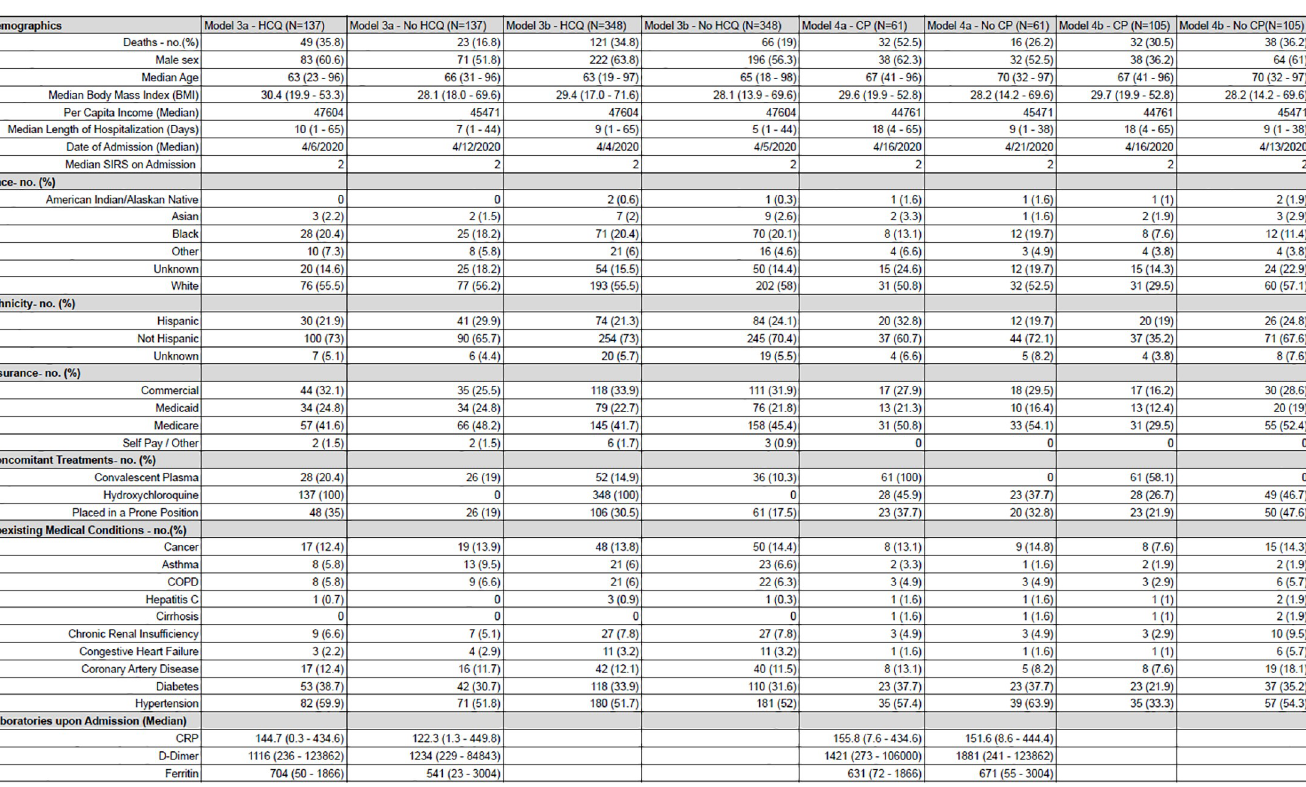
Fig 4. Demographic data for propensitiy score matching of hydroxychloroquine (HCQ) and convalescent plasma (CP) groups. (A) Propensity score matching was used to create a number of cohorts, and demographics for each cohort are shown in the table above. Model 3a and 3b separate groups with respect to hydroxychloroquine, and model 4a and 4b with respect to convalescent plasma. Percentages of each group are expressed in parenthesis for categorical variables and ranges for continuous. Race and ethnicity are self-reported. Models 3a and 4a included lab values for matching.